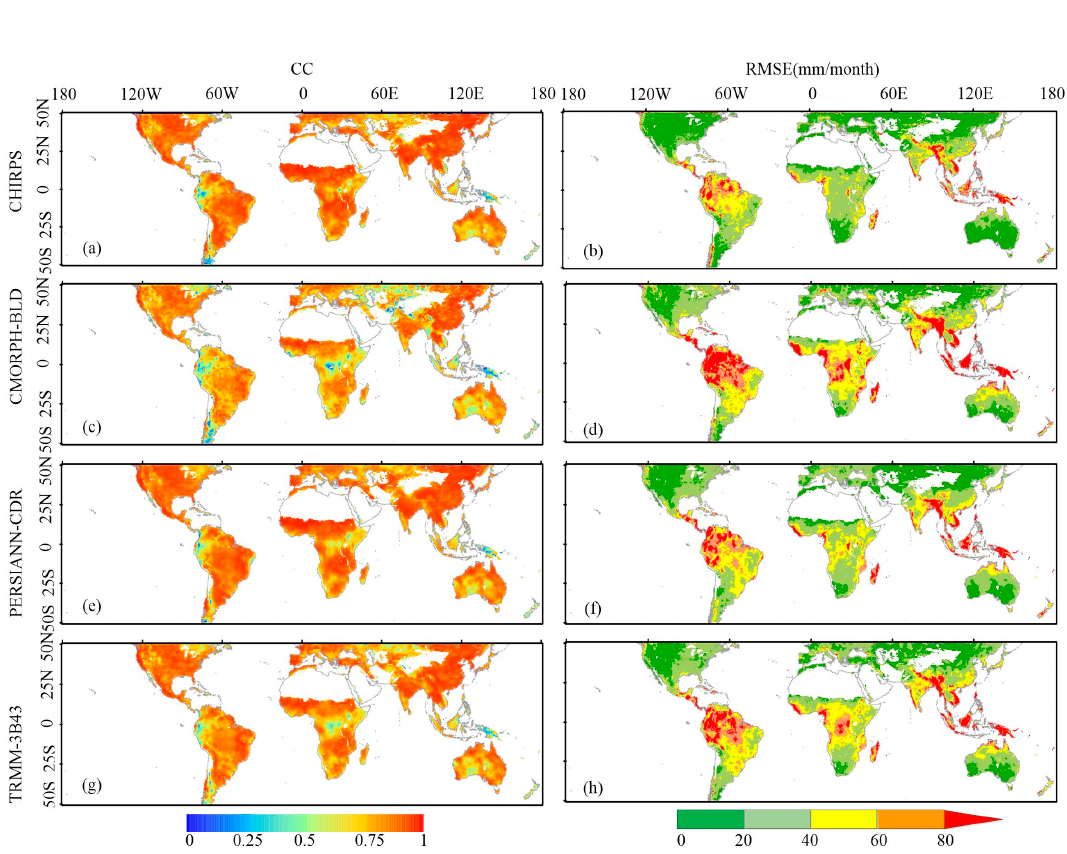
Figure 2. Spatial grid distributions of correlation coefficient ( CC ) and root-mean-square error (RMSE) between QPE product precipitation estimates and CRU observations from 2000 to 2016 ( a – h ).